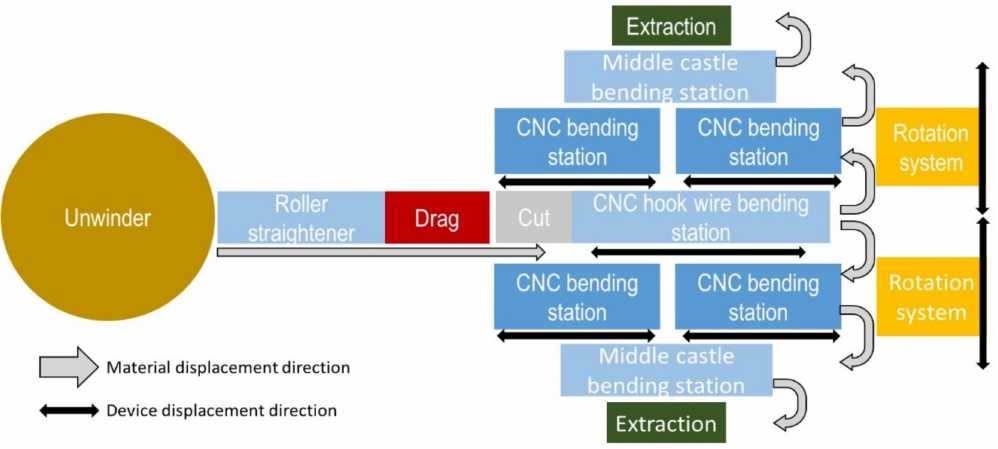
Figure 17. New concept of high-productivity/high-flexibility wires bending machine.